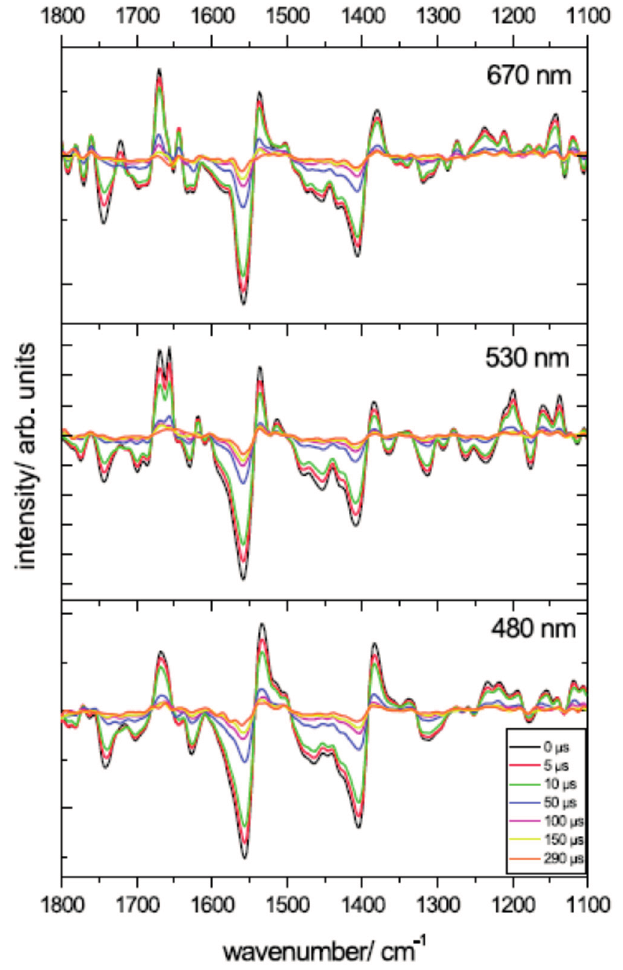
Figure 7. Step-scan FTIR spectra from A-PCP at different times using different excitation laser pulses. T = 298 K. Reproduced from